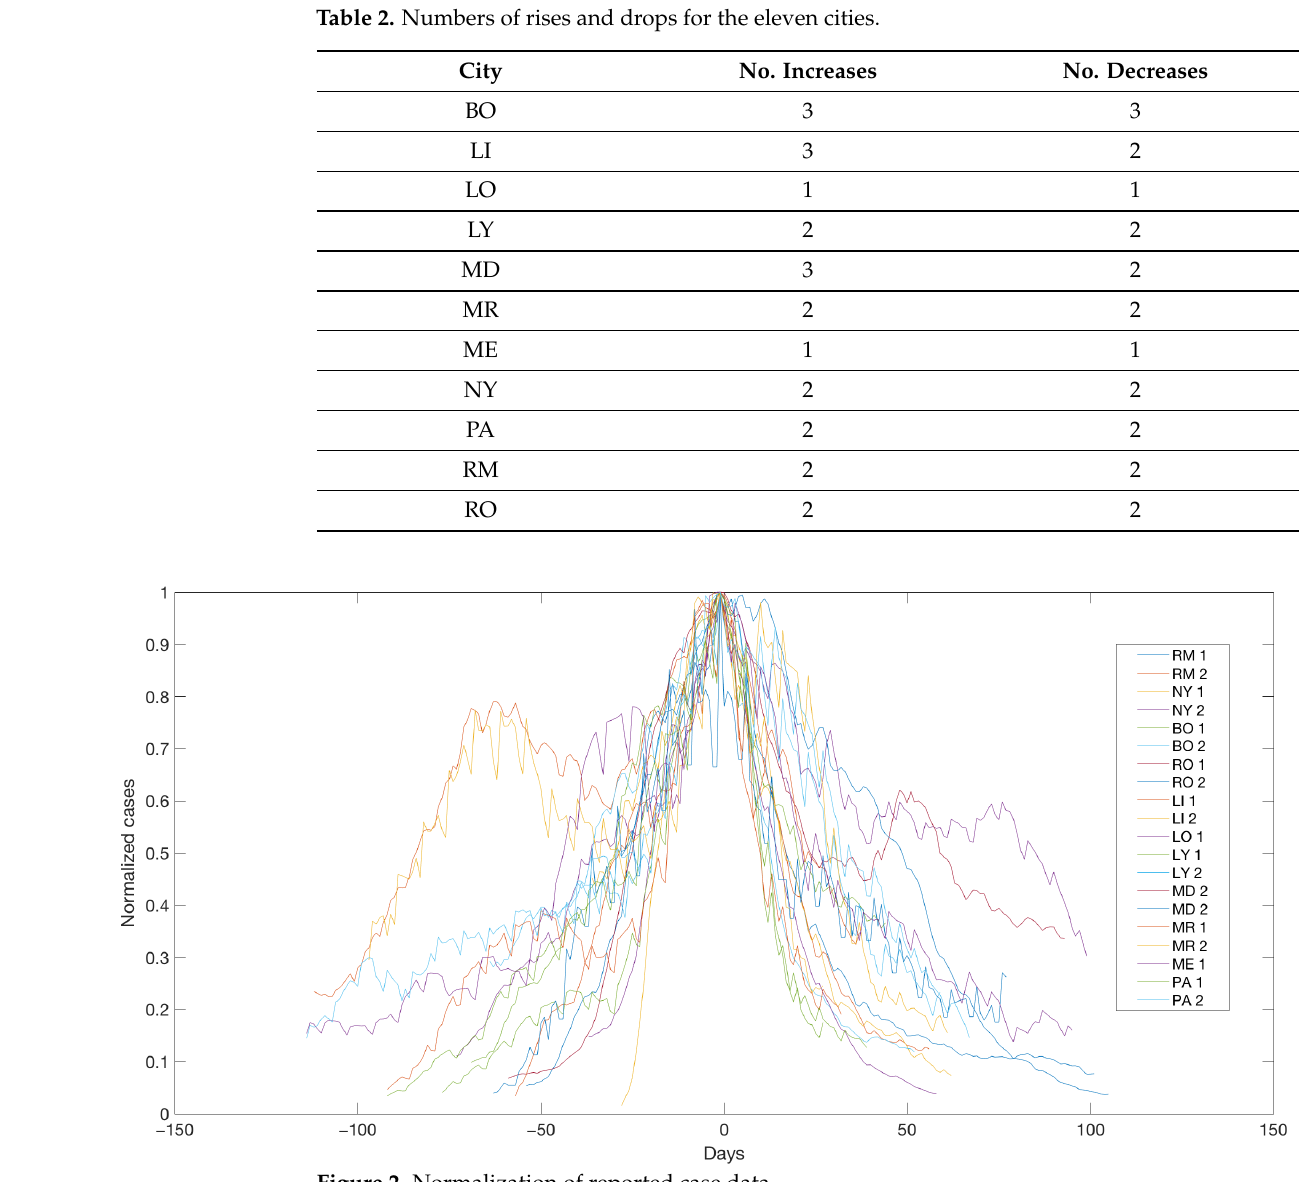
Figure 2. Normalization of reported case